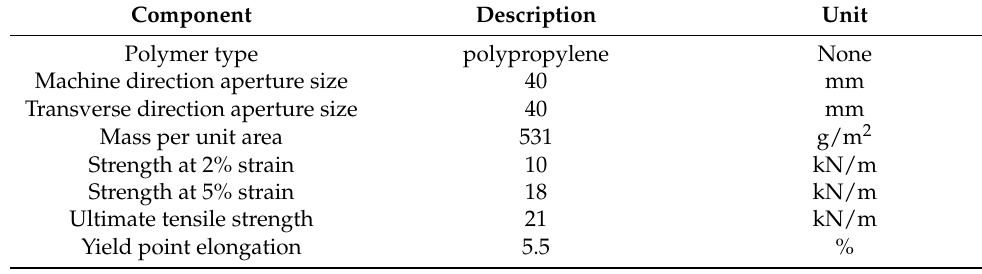
Table 3. Sample variables.